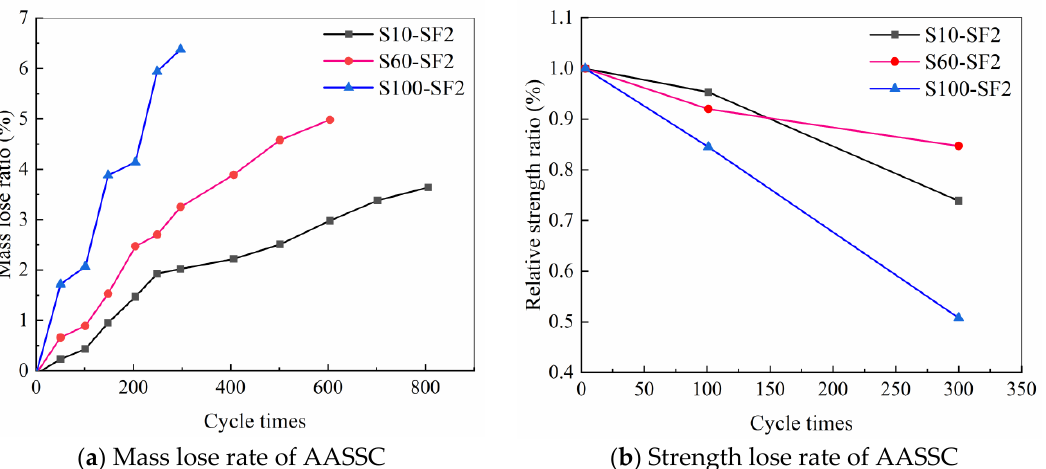
Figure 11. The effects of different substitution ratios of silicomanganese slag on sample’s resistance to freeze-thaw test.